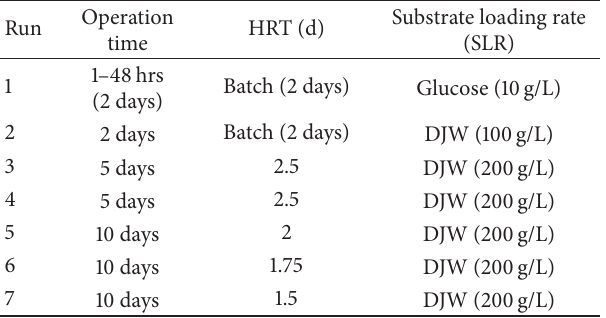
Table 1: Operation strategies of the ASBR.